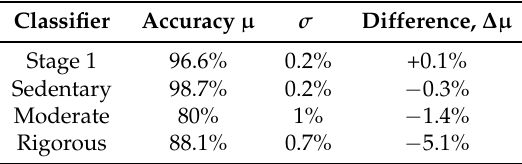
Table 3. On-Board Classification (effect of feature reduction).